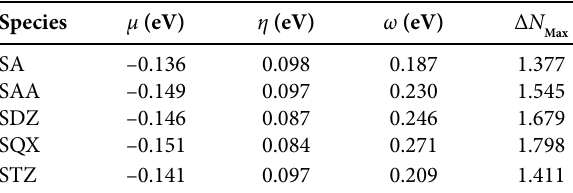
Table 5. Calculated values for electronic descriptors µ , η , ω , and Δ N for studied SAs. Max